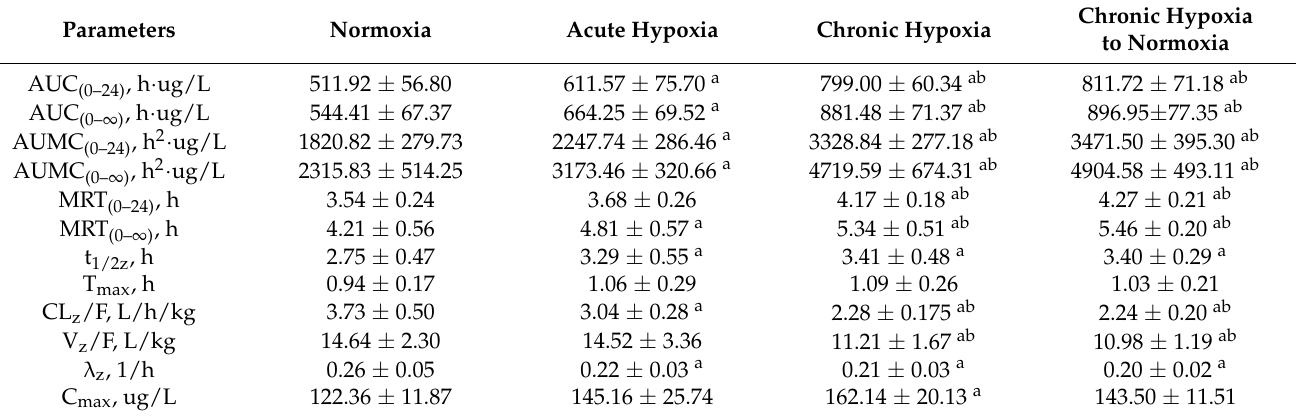
Table 5. Pharmacokinetic parameters of nifedipine in rat plasma after exposure to high-altitude